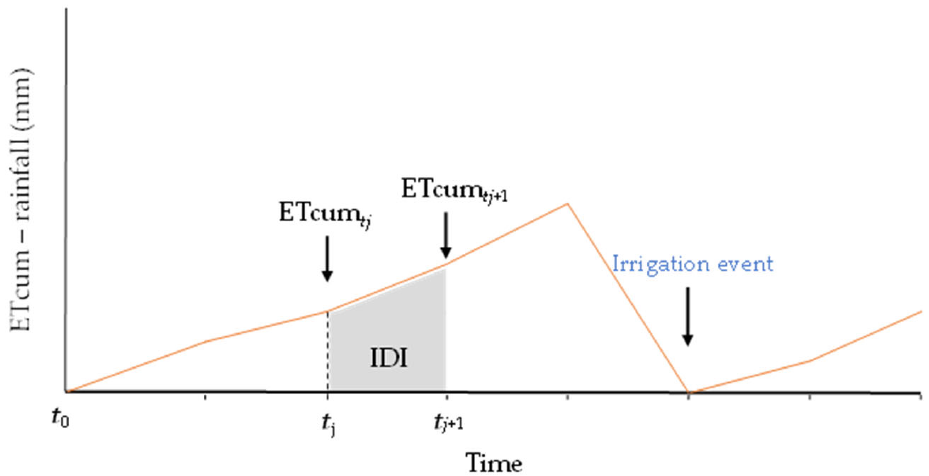
Figure 1. Representation of how the irrigation deficit integral (IDI) was calculated for each time interval as per Equation (1). The first and last periods between irrigation events are triangles; however, the trapezoid area was still used in these instances as one side equaled zero.